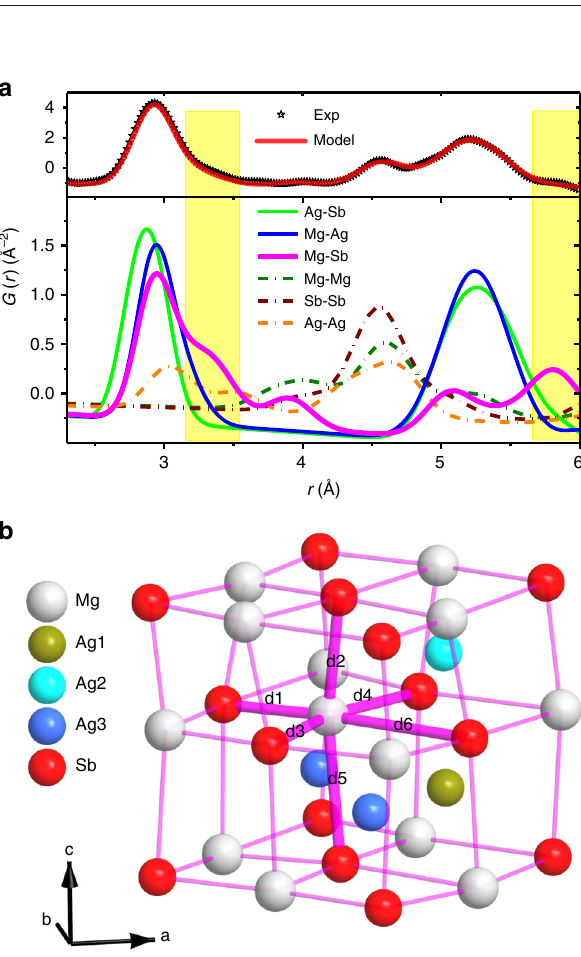
Fig. 1 Neutron diffraction measurements demonstrate that MgAg 0.965 Ni 0.005 Sb 0.99 maintains the α -MgAgSb tetragonal structure from 20 to 500 K. a Crystalline structure of α -MgAgSb with a complex distorted Mg – Sb rocksalt sublattice, where half of the Mg – Sb distorted cubes are fi lled with Ag atoms. b Rietveld re fi nement of MgAg 0.965 Ni 0.005 Sb 0.99 neutron diffraction data measured at 300 K. c Temperature-dependent MgAg 0.965 Ni 0.005 Sb 0.99 neutron diffraction data. These data reveal that MgAg 0.965 Ni 0.005 Sb 0.99 maintains the same α - MgAgSb tetragonal structure with a space group of I − 4 c 2 (no.120) over a temperature range from 20 to 500 K. The 450 and 500 K data show the appearance of a small amount of Sb precipitate; a.u., arbitrary units.